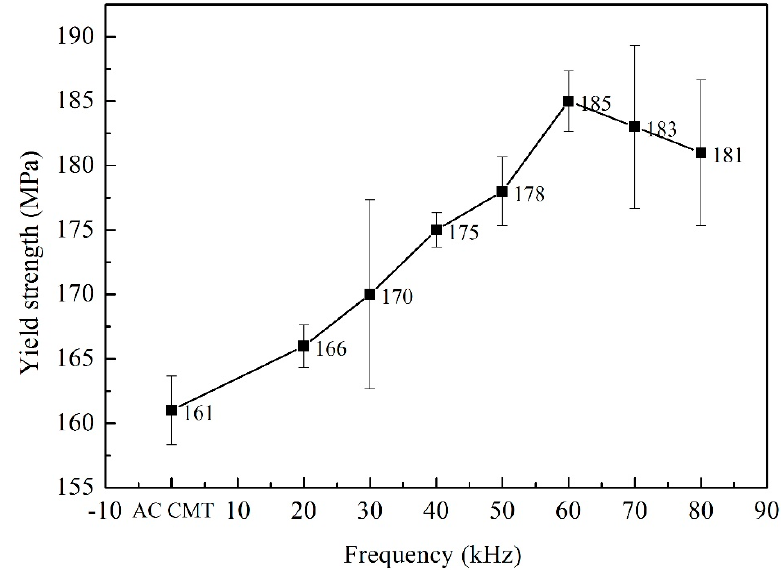
Figure 11. The yield strength of joints welded by AC CMT and AC CMT coupled current at frequency of 20 kHz, 30 kHz, 40 kHz, 50 kHz, 60 kHz, 70 kHz and 80 kHz, respectively.